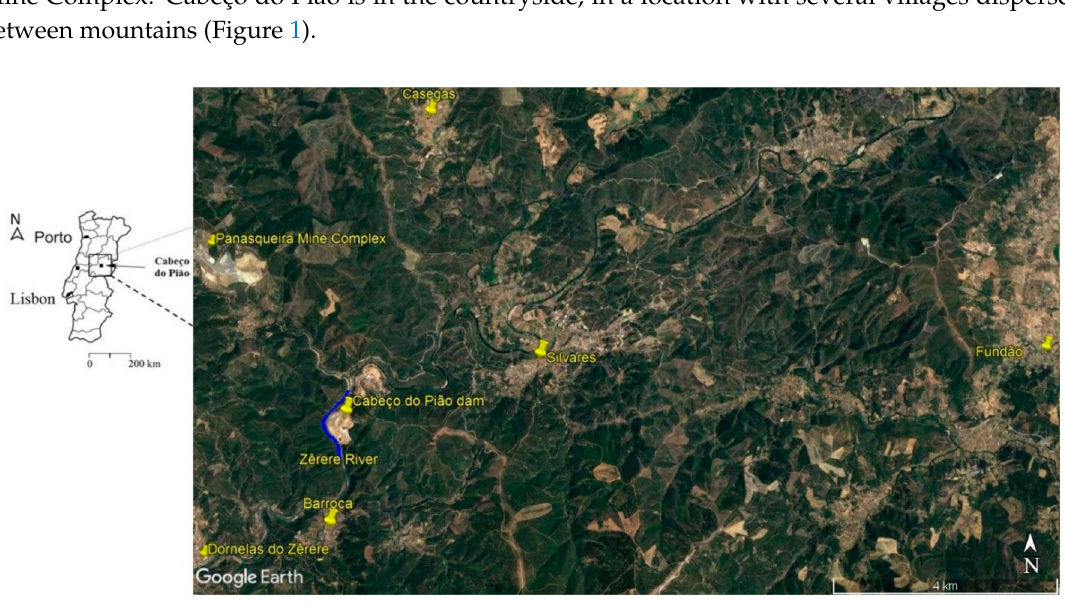
Figure 1. Cabeço do Pi ã o dam location in Portugal and surrounding villages. Map data: Google Earth Pro, Maxar Technologies